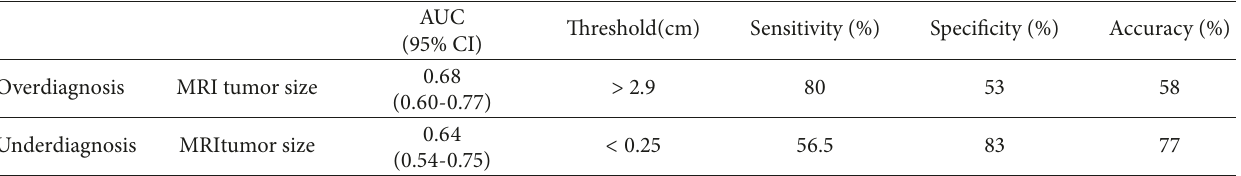
Table 6: Clinical performance of the cut-off lesion size measured on MRI to predict the effect of large tumor size for misdiagnosis (overdiagnosis and underdiagnosis) with optimal